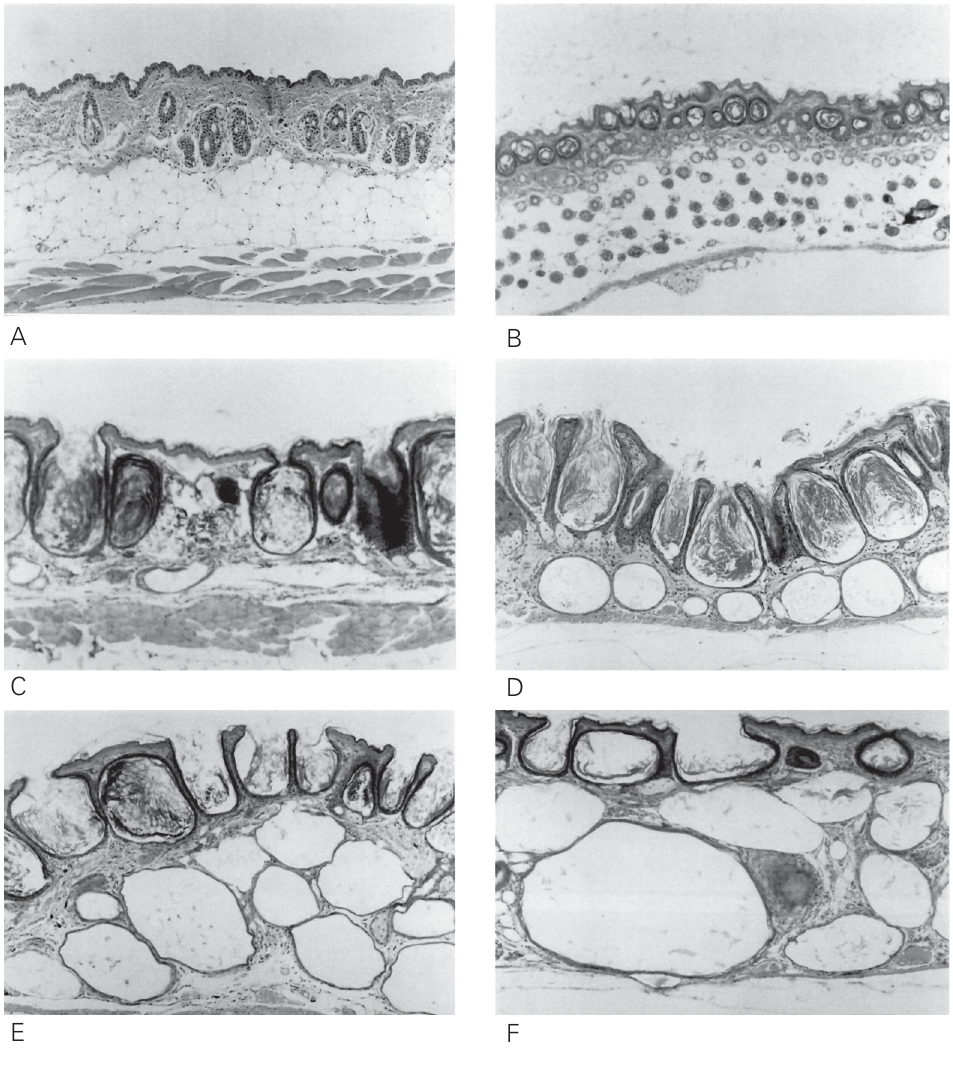
Figure 1. Photomicrographs of skin from BALB/c (A) and hr USP mice at 18 days of age (B), 30 days (C), 90 days (D), 180 days (E), and 240 days (F) (H&E, 165X). See the increase in thick- ening and the formation of utricles and cysts in the dermis.